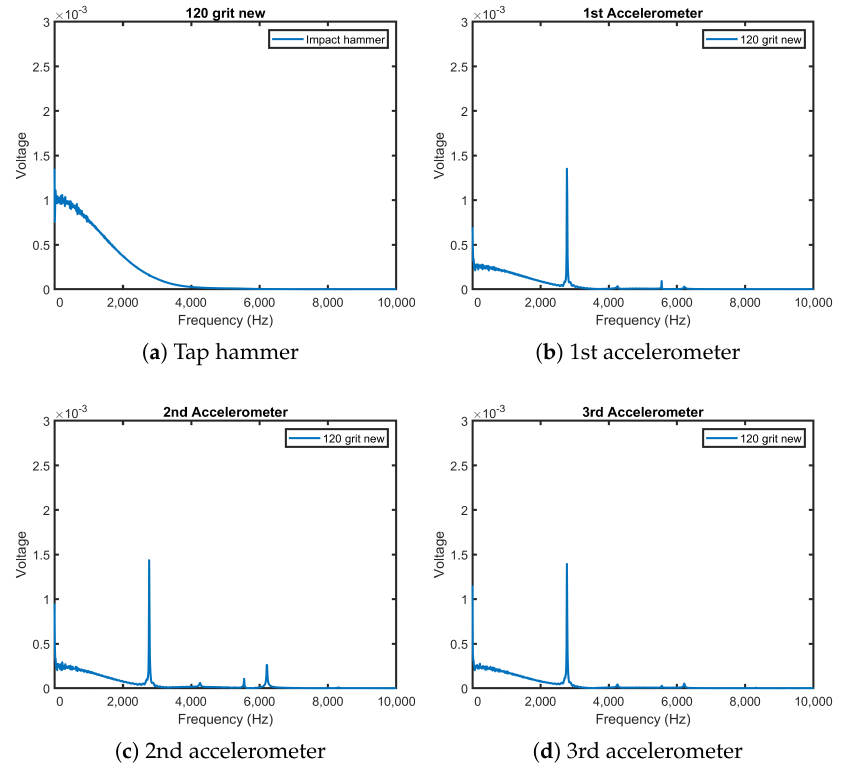
Figure 16. Typical natural frequency result of the new 120 grit